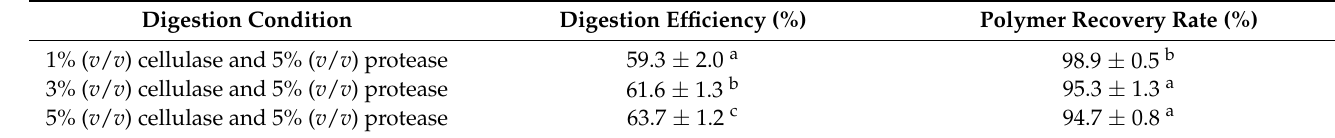
Table 1. Digestion efficiency and polymer recovery rate observed for the enzymatic method for G. fisheri